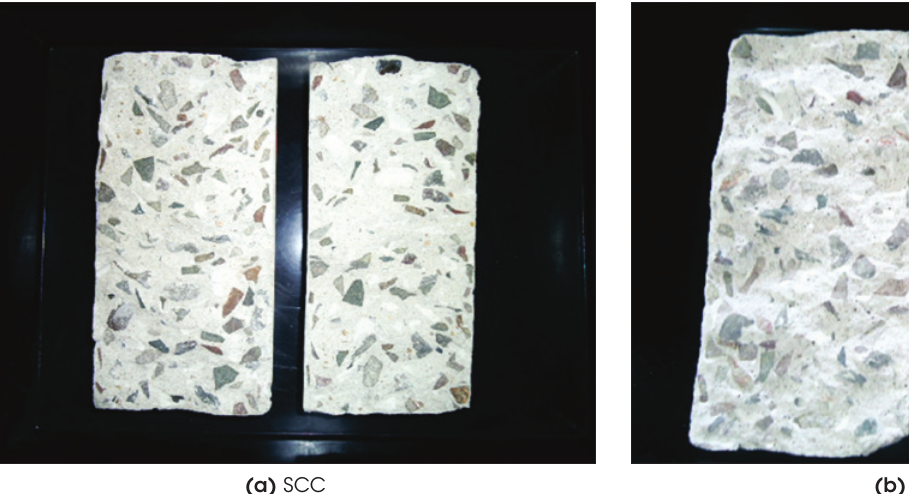
Figure 5 Specimens ruptured by diametral